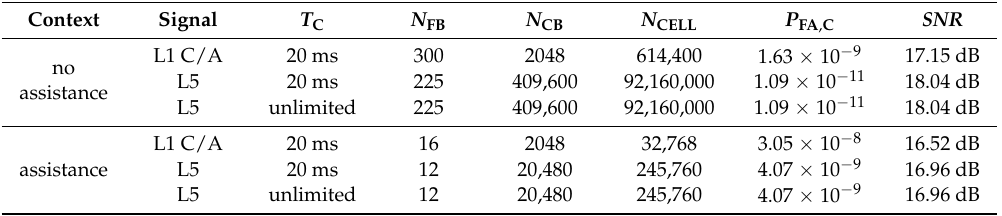
Table 4. Search space and statistical parameters for P FA,G = 10 − 3 and P D = 0.9 for different contexts with GPS